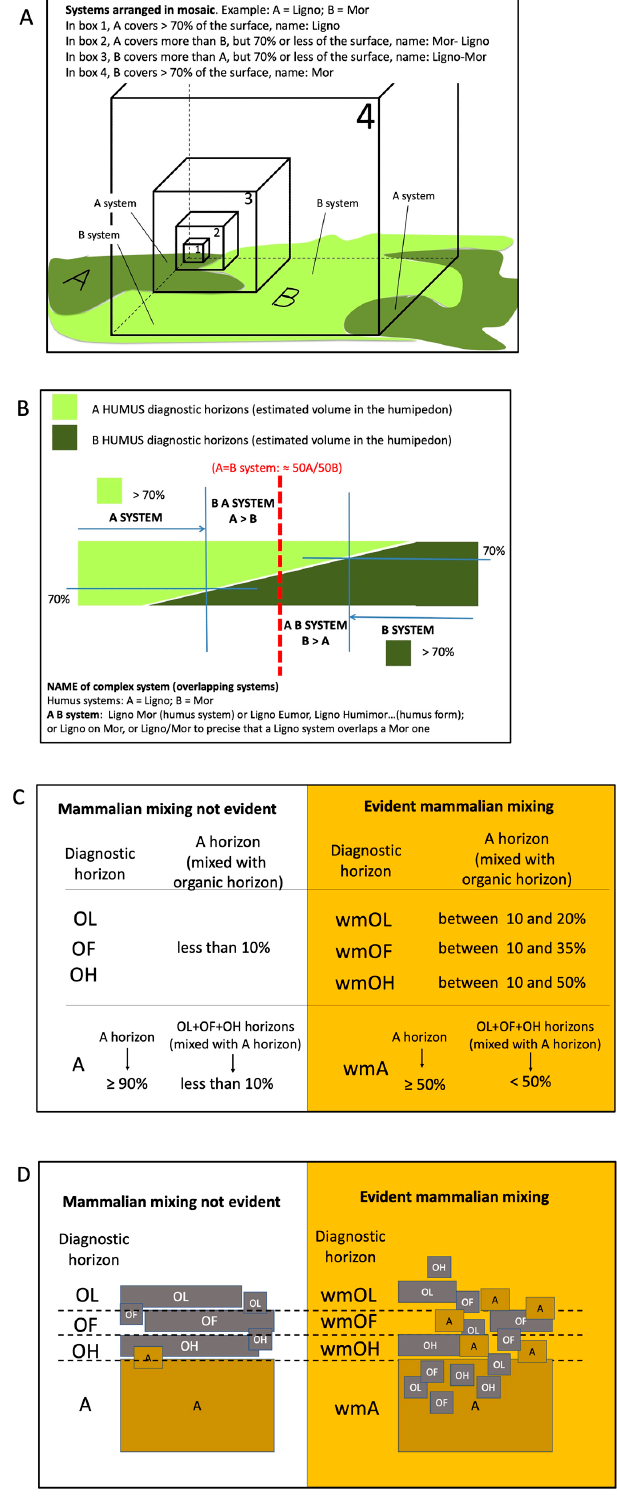
Figure 7. To simplify complexity: humus systems arranged in mosaic ( A ) or overlapping ( B ); diagnostic horizons broken down by wild mammals, definition ( C ) and schematic drawing ( D ). Generally,